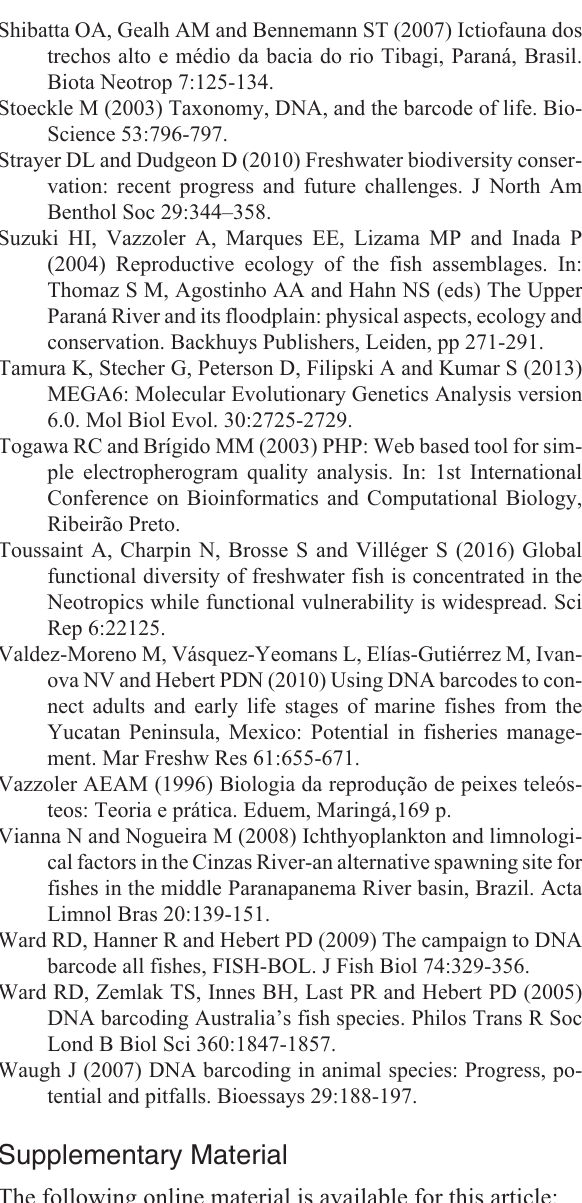
Figure S1 - Egg morphotypes defined a priori. Table S1 - Species identified from eggs from the main tribu - taries of the Capivara